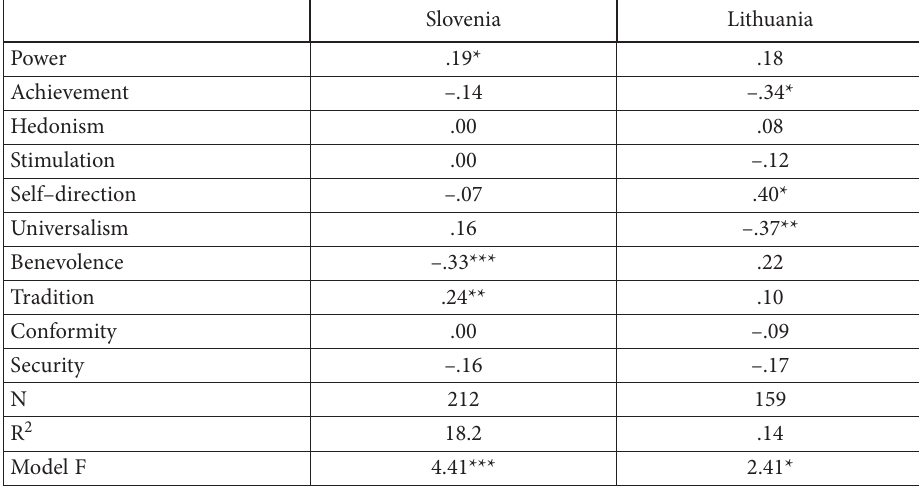
Table 5. Regression analysis results for the impact of personal values on organizationally beneficial behavior (created by the authors) Slovenia Lithuania .19* .18